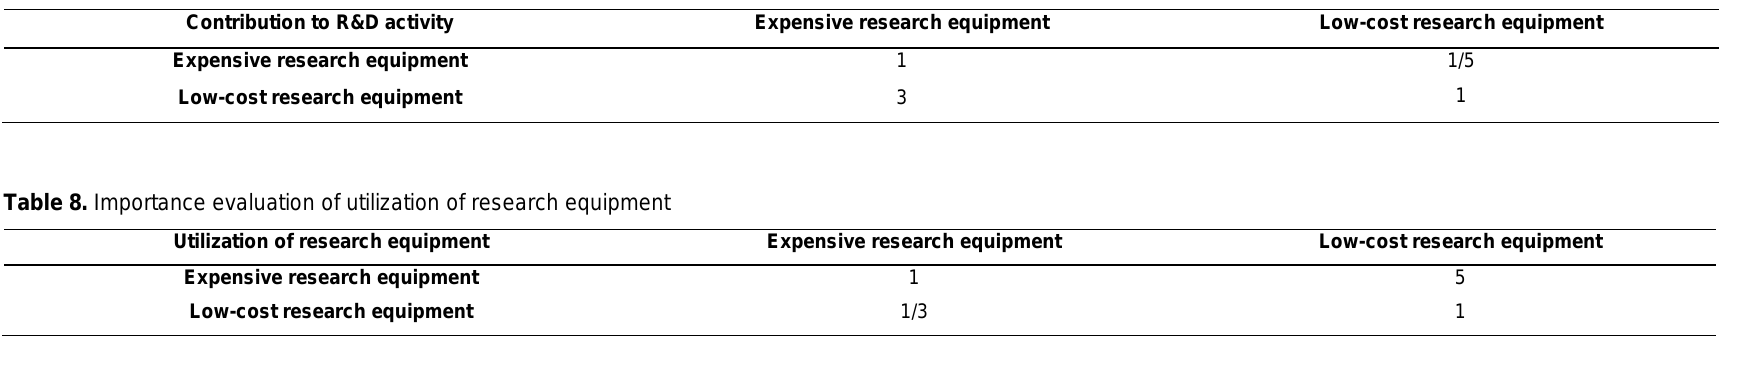
Table 7. Importance evaluation of contribution to R&D activity